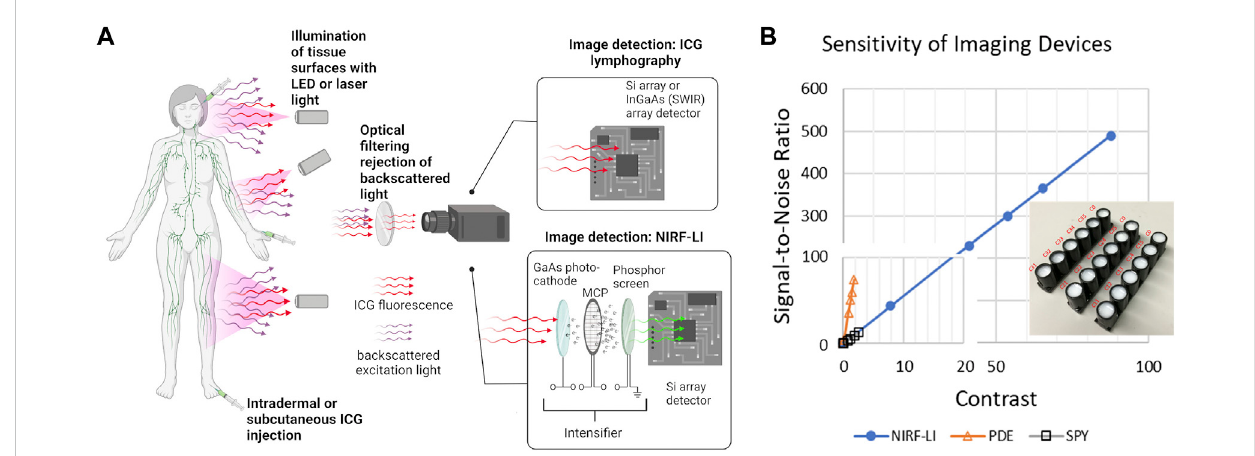
FIGURE 2 (A) Simpli fi ed schematic of near-infrared fl uorescence imaging for non-invasive monitoring of lymphatic anatomy and function that employs ICG fl uorescent contrast administration, illumination of tissues, optical fi ltering of backscattered excitation light, and collection of fl uorescent light for imagingusingICGlymphographyornear-infrared fl uorescencelymphaticimaging(NIRF-LI).CreatedusingBiorender. (B) Useofsolidworkingstandards (insert) for comparing performance betweenintensi fi ed(NIRF-LI)and commercial, non-intensi fi ed near-infrared fl uorescence devices Hamamatsu PDE and Novadaq ISPY, reproduced from (Zhu et al., 2014; Aldrich et al.,